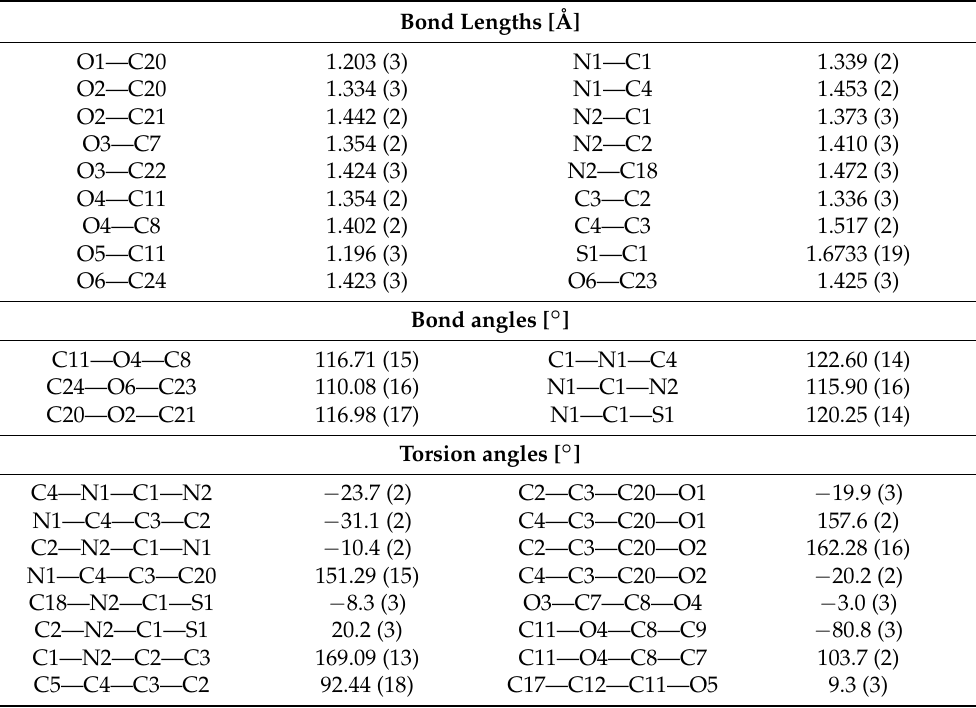
Table 1. Selected geometrical parameters for methyl 4-(4 (cid:48) -benzoyloxy-3 (cid:48) -methoxyphenyl)- 1,2,3,4- tetrahydro-1,6-dimethyl-2-thioxopyrimidine-5-carboxylate ( 4j ).